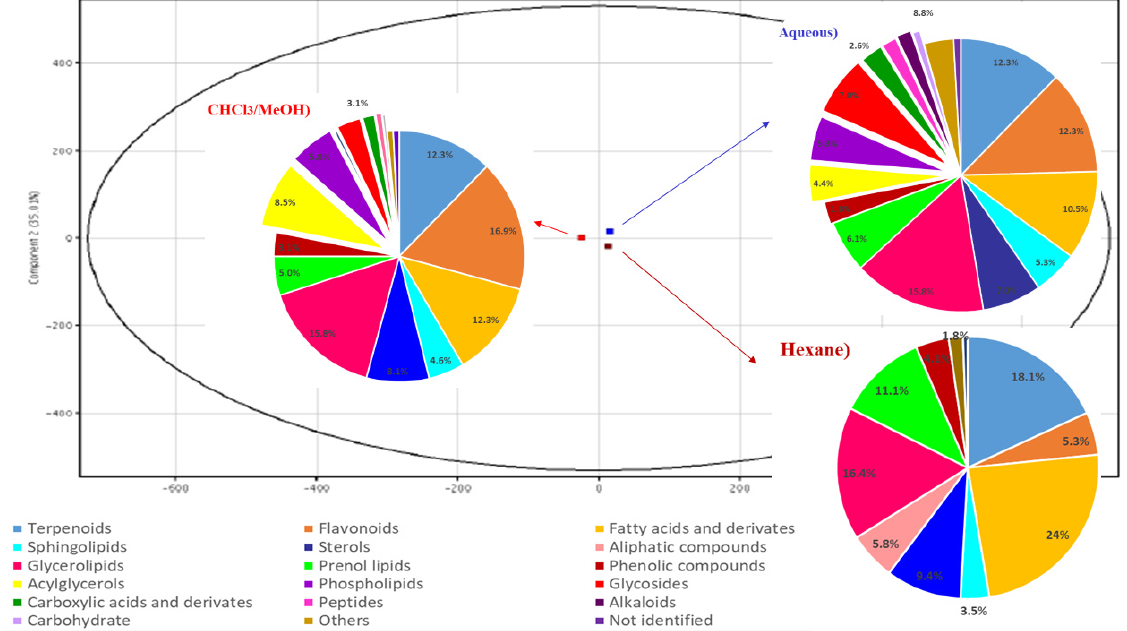
Figure 1. PCA plot of C. incisa leaves extracts. PC1 (64.99%), PC2 (35.01%). Within the PCA graph the hexane extract is represented with brown color, CHCl 3 /MeOH in red and the aqueous one in blue. Different classes of metabolites identified in each extract are also represented.